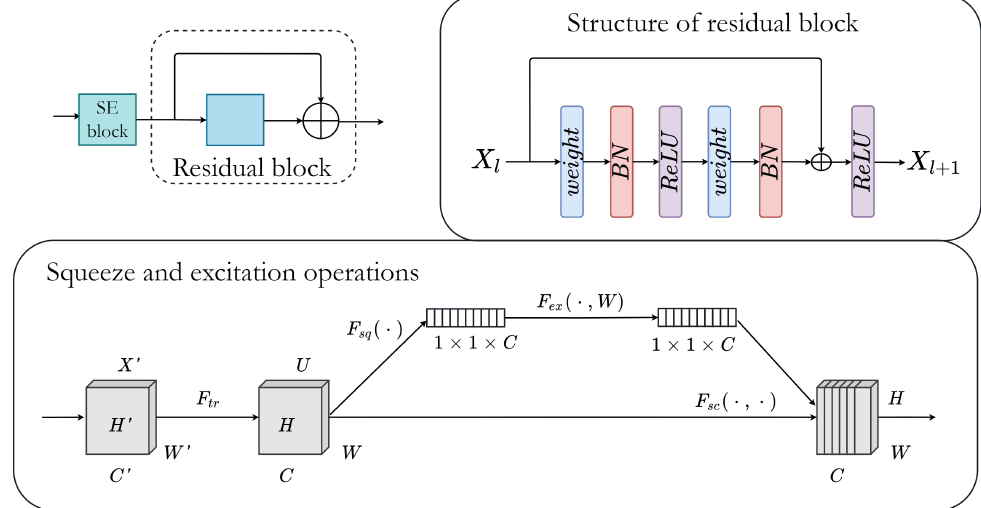
Figure 2. The structure of the residual and squeeze and excitation